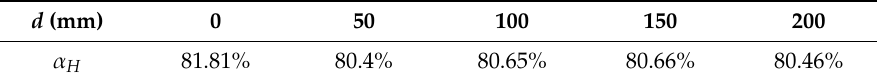
Table 4. Comparison of the horizontal stability of the external receiver